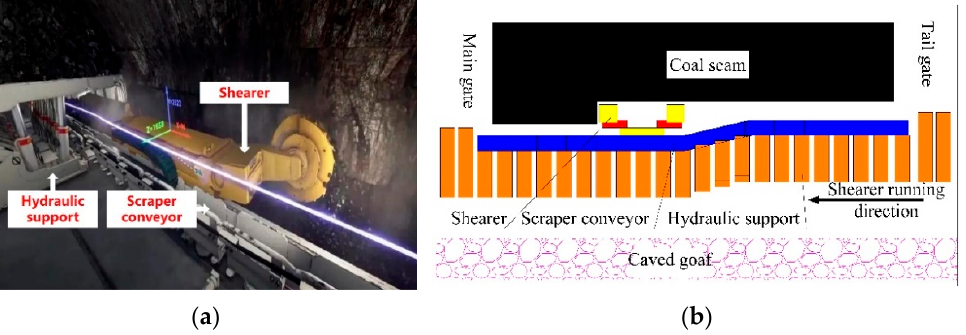
Figure 1. Layout of three machines at a typical fully mechanized mining face; ( a ) front view; ( b ) top view. ( b ) top